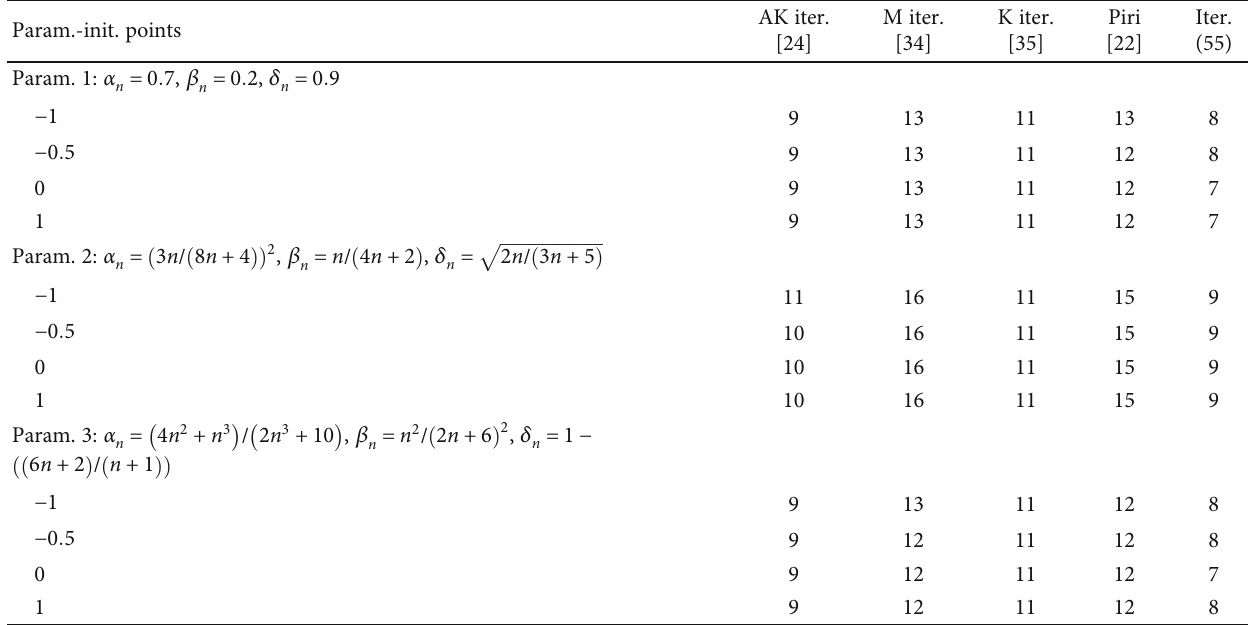
Table 2: In fl uence of parameters and initial points.